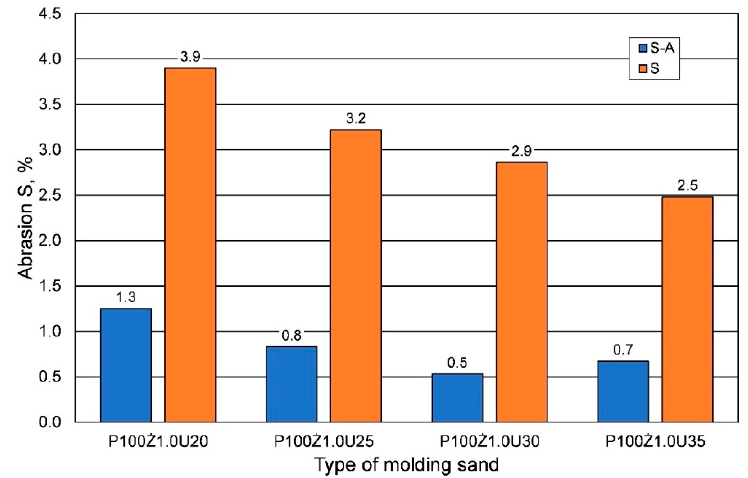
Figure 12. Abrasion S of hardened molding sand (after 24 h) prepared on the basis of fresh chromite sand, depending on weather conditions, for different amounts of added hardener.